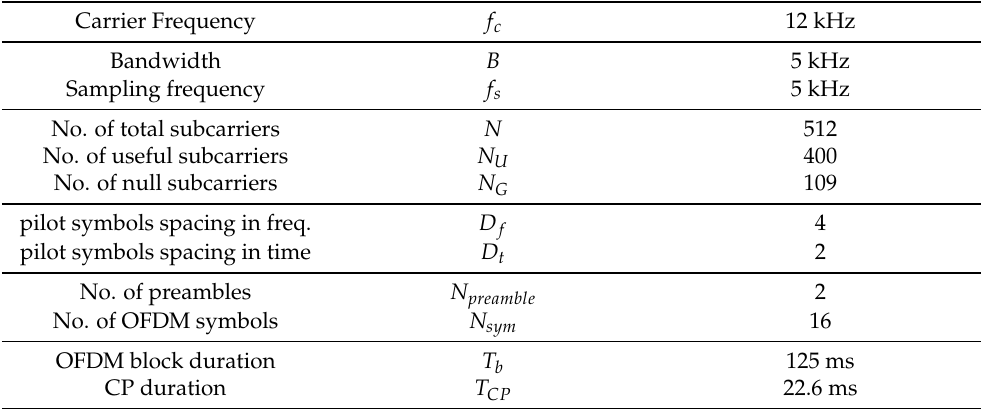
Table 1. Parameters of the UWA OFDM